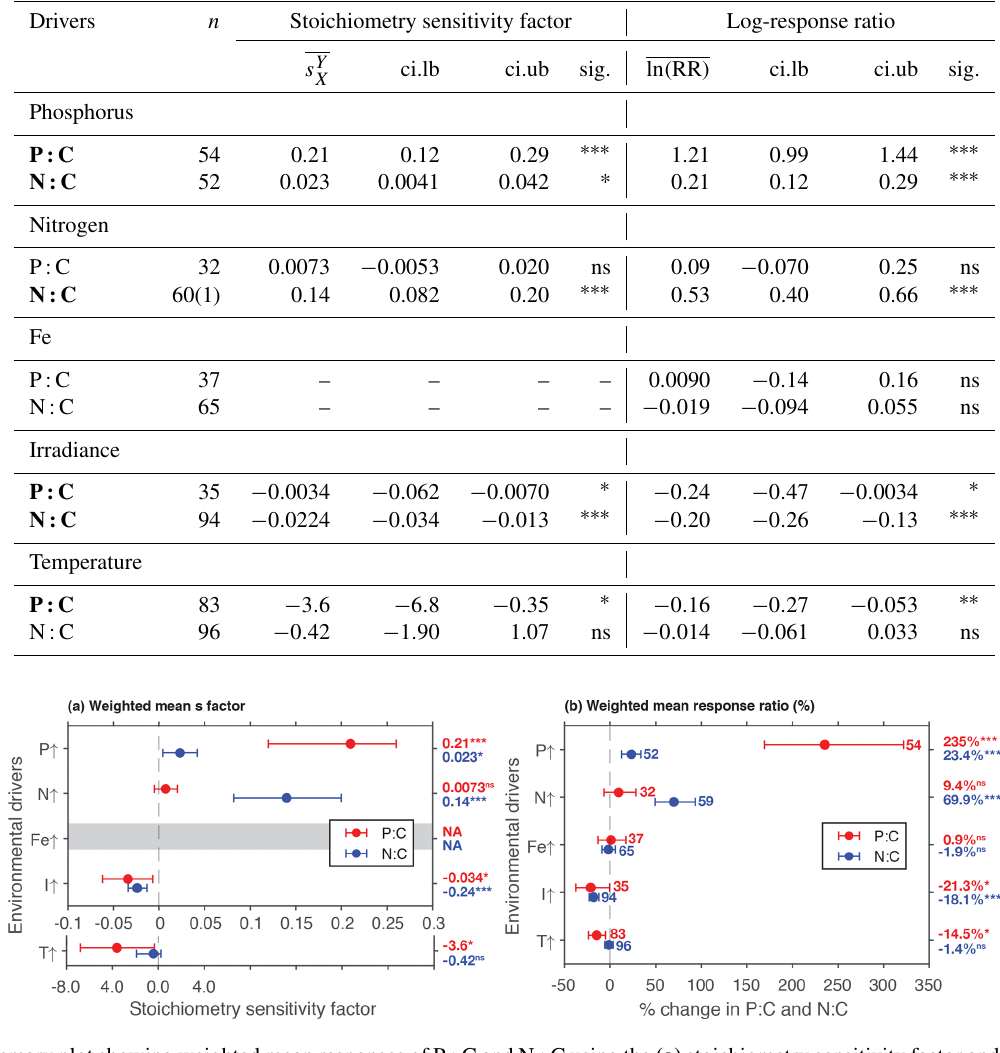
Figure 2. Summary plot showing weighted mean responses of P : C and N : C using the (a) stoichiometry sensitivity factor and (b) % changes between control and treatment. Numbers next to the plots in (b) correspond to the number of experimental units, and the numbers are identical in (a) . Numbers in the outside column are the weighted means. ∗ P < 0 . 05; ∗∗ P < 0 . 01; ∗∗∗ P < 0 . 001; ns, not significant. Note that the x axis is different for temperature experiments in (a)